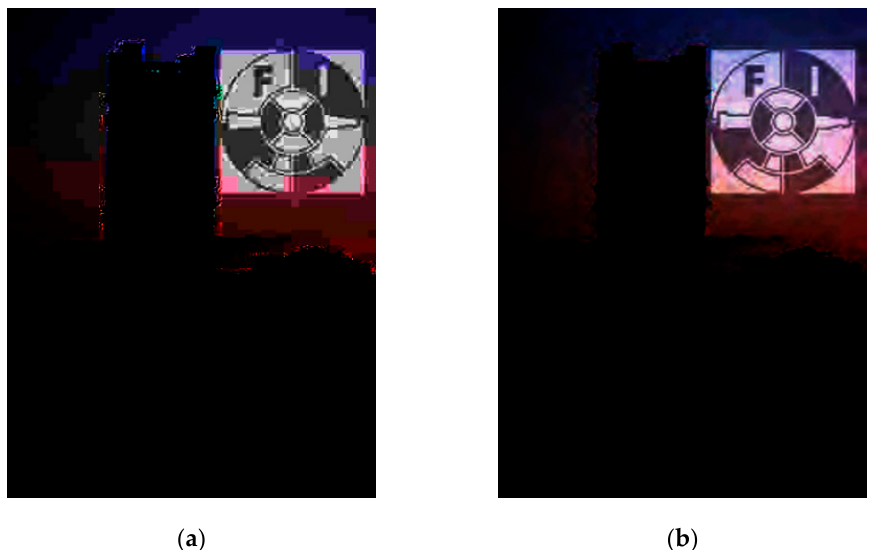
Figure 19. Robustness of the owner logotype as watermark against: ( a ) JPEG QF = 40, and